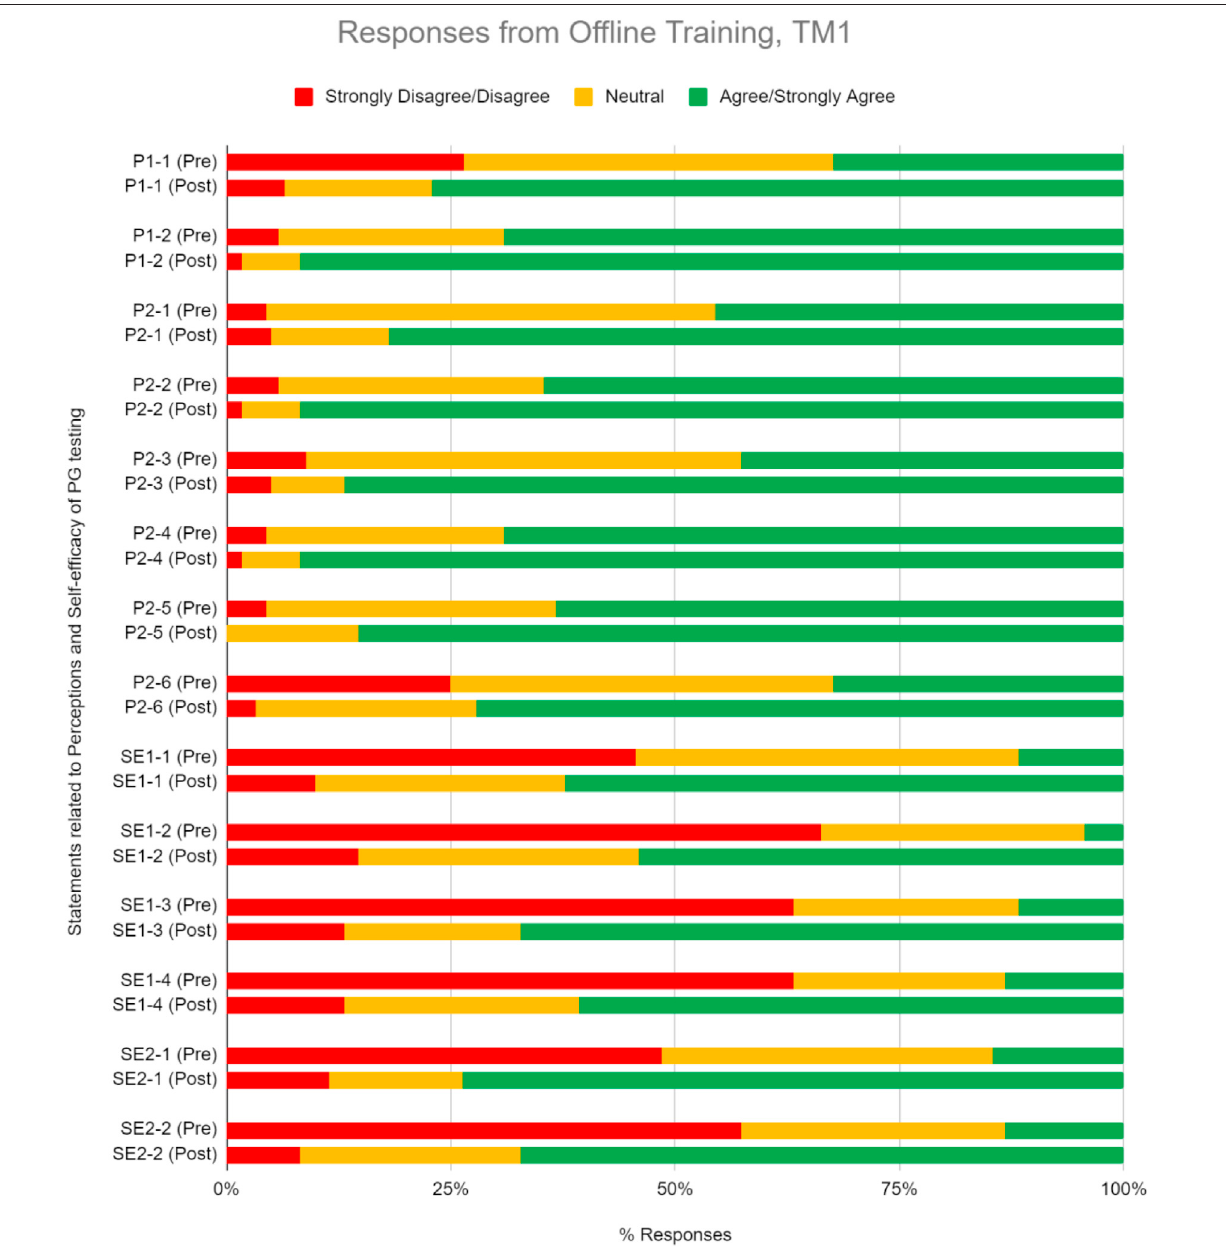
utility of PGx tests after attending the training.